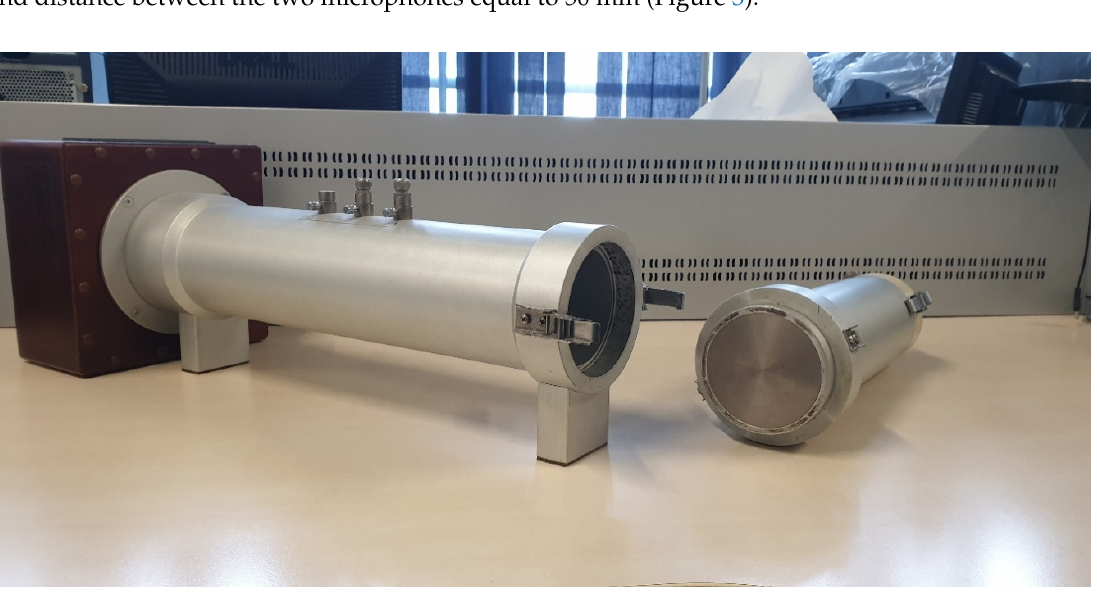
Figure 3. Impedance tube for measuring the absorption coefficient at normal incidence.